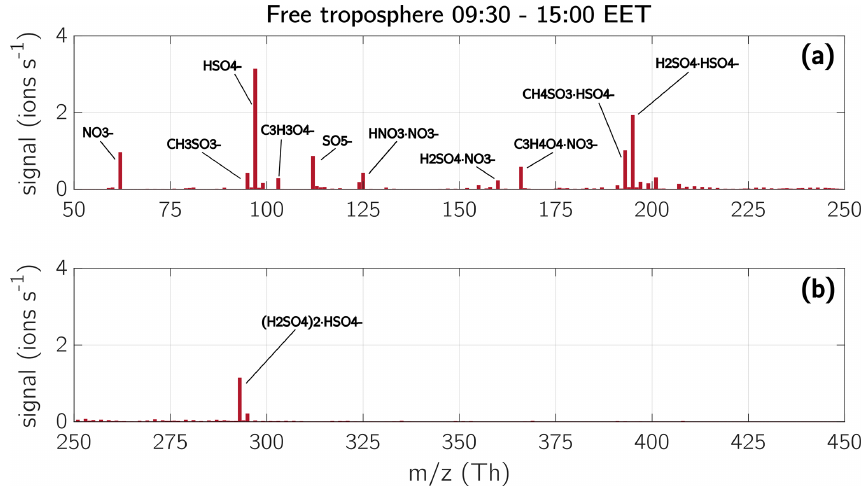
Figure 17. Mass spectra of the free troposphere during daytime. The spectra are a median of six measurements in the FT during daytime between 09:30–15:00EET. The chemical composition of the ions with the highest signal are shown in the spectra. Panel (a) shows the masses from 50–250Th, panel (b) from 250–450Th. The temperature in the FT at measurement height during afternoon on all measurement days was between − 8 and 3 ◦